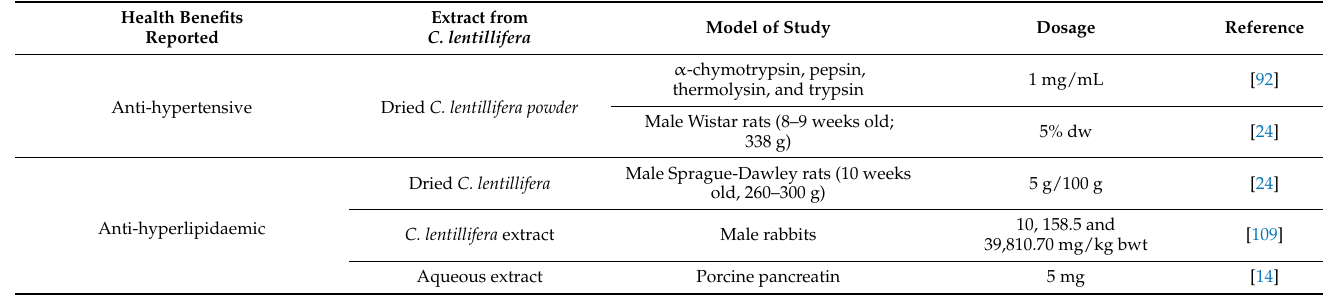
Table 8. Health benefits reported in Caulerpa lentillifera